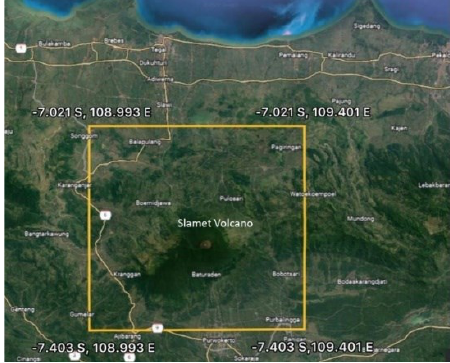
Fig. 4. Location of study area; Slamet Volcano and its surrounding area (Source; Google Earth)